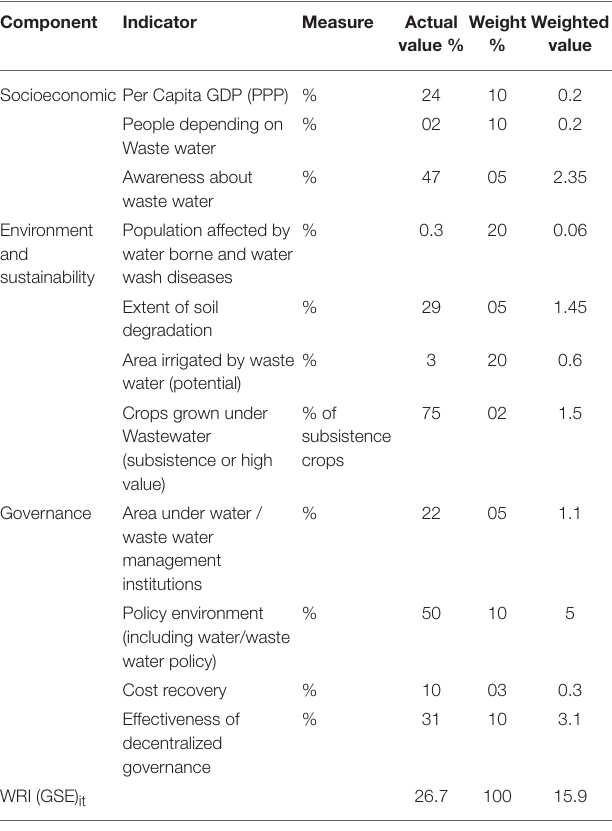
TABLE 3 | Governance and socioeconomic component index of wastewater reuse effectiveness index developed based on data for India (WRI-GSE).